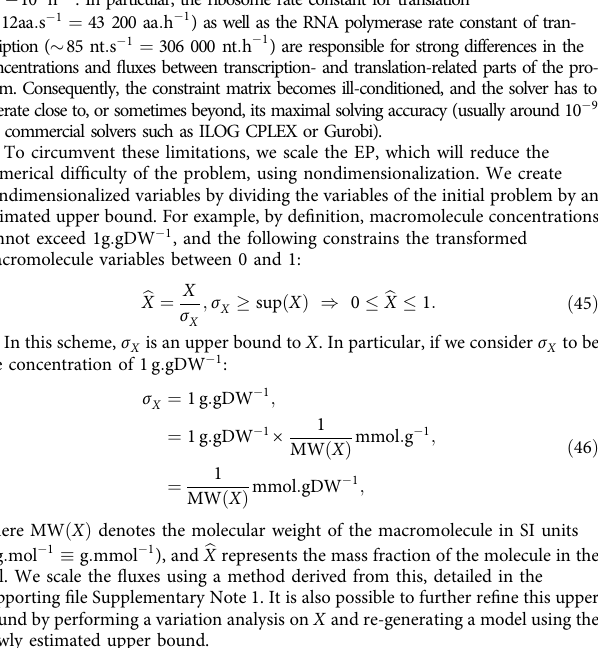
Scaling . Acriticalissueintheformulationofthisproblemisthatthevariablesaredifferent orders of magnitude.Fluxes are typically between 10 (cid:4) 3 (cid:4) 10 1 mmol : gDW (cid:4) 1 : h (cid:4) 1